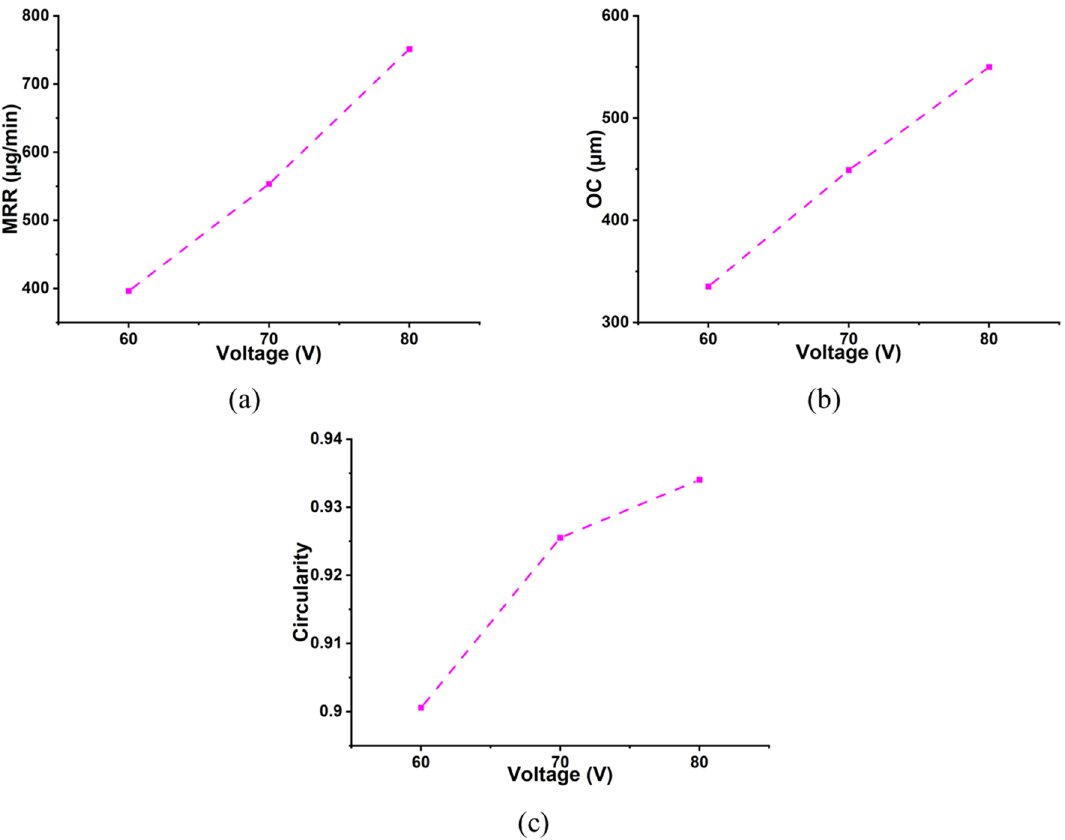
Figure 6. Influence of voltage on machining characteristics ( a ) MRR, ( b ) OC, and ( c ) bottom but Fig. 5c clearly shows that sparking occurs at the bottom of the tool surface along with side sparking enhancing the depth of penetration. Influence of voltage on machining characteristics. The ES-µ-ECDM system is used for the sonica- tion of the electrolyte, and voltage plays a prominent role in the micromachining of commercially pure titanium workpieces. Stabilizing the spark and spark intensity depends on the gas film’s thickness and voltage, aiding assistances like sonication 52 . The effect of voltage on the machining characteristics is shown in Fig. 6. It can be observed that increasing the voltage from 60 to 80 V increased all the machining characteristics. Ultrasonication provided to the electrolyte helped reduce the gas bubble’s departure radius, resulting in gas bubbles with a thin and more stable gas layer. The latter leads to the channelized spark under the tooltip and thus, increasing the depth of penetration and generating through-holes at higher levels of voltage. The rise in voltage increased the spark intensity at the machining zone enabling a higher MRR. As a result of the increase in voltage from 60 to 80 V, an average percentage increase in MRR of 89.67%. The increase in spark intensity also increases the OC and circularity associated with the machined hole. The percentage increase in OC and circularity with an increase in voltage from 60 to 80 V, keeping concentration and duty factor constant at 20 wt% and 50% DF, is 73.91% and 0.44%, respectively. The average percentage increase in OC and circularity with a surge in voltage is 64.09% and 3.71%, respectively. The SEM images in Fig. 7 show the rise in OC and circularity. As the spark intensity increases, there is an evident increase in OC, but the increase in hole circularity might be due to proper melting and vaporization of the workpiece at higher voltages. The rise in OC also states the evidence for a rise in MRR. It is also observed that with an increase in voltage the HAZ increases but the formation of the passivation layer was seen to be less. This might be because higher spark intensity due to a surge in voltage increased the HAZ and does not allow the formation of a passivation layer. As the spark hindered the formation of the passivation layer the depth of penetration increased and through-holes are achieved at a higher voltage of 80 V. Influence of electrolyte concentration on machining characteristics. The sonication of electro- lytes helps flush debris out and circulate fresh electrolytes at the machining zone. The increase in electrolyte concentration increased the number of conducting ions, thus, increasing the spark intensity. The aiding of son- ication to the system increased penetration depth, which eventually resulted in through-hole formation. As shown in Fig. 8, the plots elucidate the effects of electrolyte concentration on the machining characteristics. The increase in concentration from 20 to 30 wt% enhanced all machining attributes. The surge in MRR, OC, and cir- cularity can be attributed to the increase in anodic dissolution and intensity of the spark because of an increase